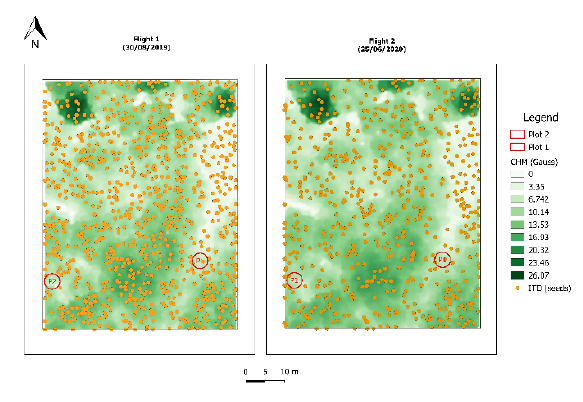
Figure 6 . Individual tree crowns detection